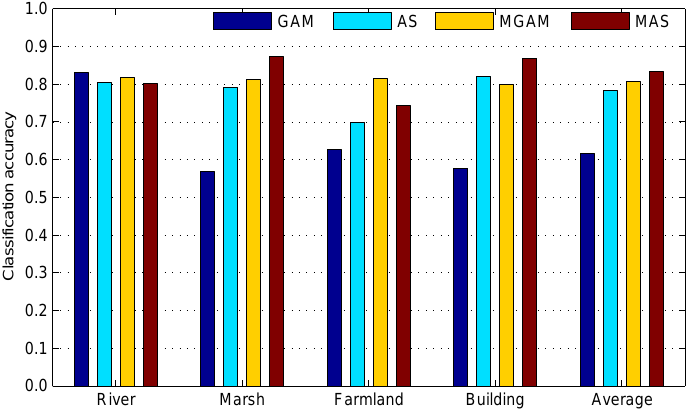
Figure 9. Classification accuracies of different classifiers on Foshan dataset.